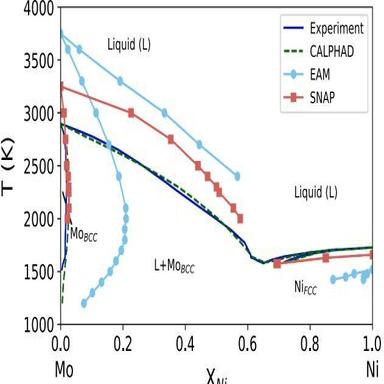
High-temperature Ni-Mo phase diagram from experiments, CAL-PHAD, SNAP, and EAM models. Reproduced with permission from Ref. .